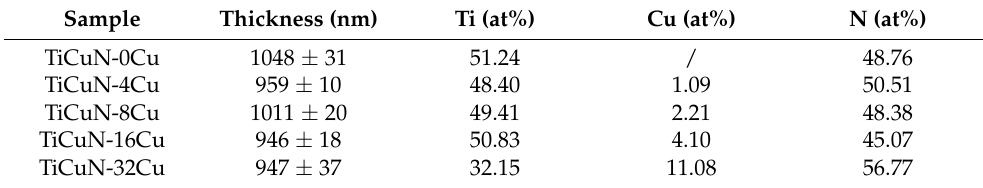
Table 2. EDS component analysis of TiCuN with different Cu contents.